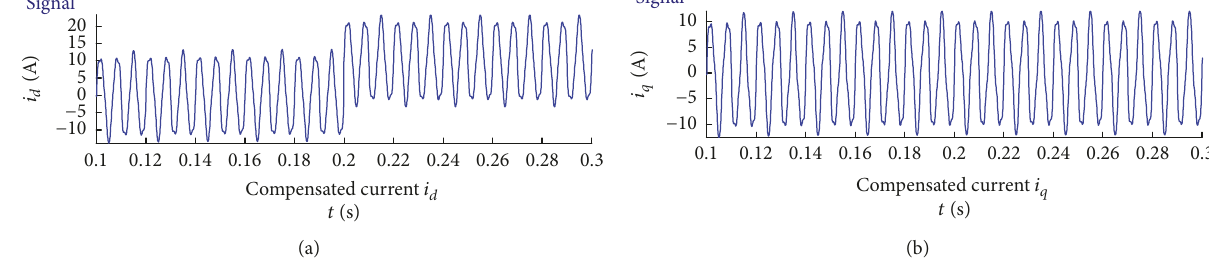
Figure 8: Compensated current in 𝑑 - 𝑞 coordinate. It is proved that 𝑖 𝑑 and 𝑖 𝑞 are completely decoupled in 𝑑 - 𝑞 coordinates.